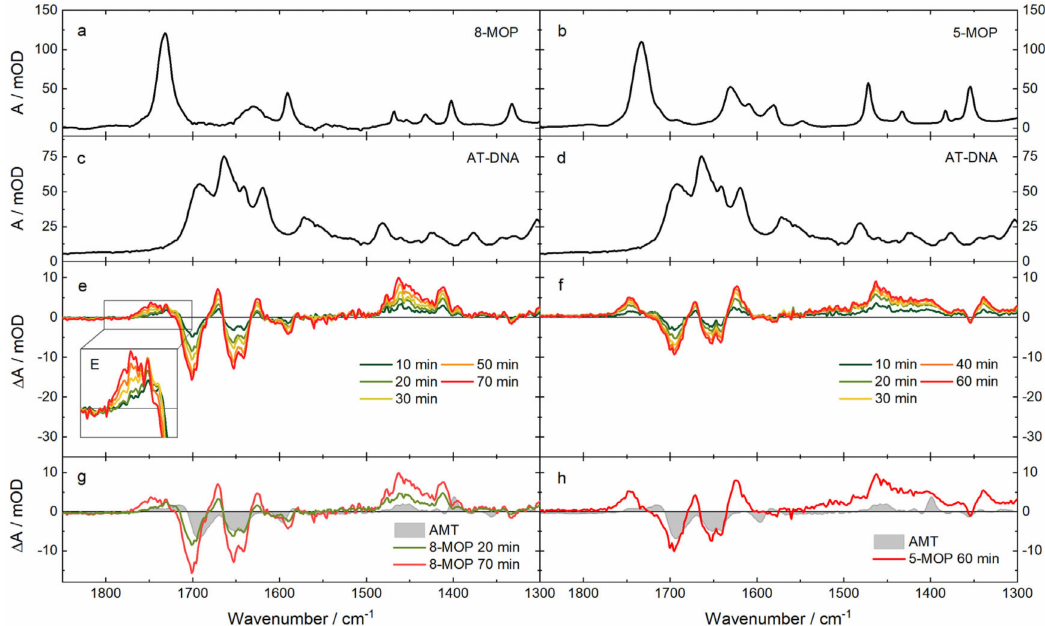
Figure 3. Steady-state IR spectra of the photoaddition of 8-MOP (left) and 5-MOP (right) to AT-DNA: ( a ) 8-MOP (11 mM) in acetonitrile-d3; ( b ) 5-MOP (10 mM) in acetonitrile-d3; ( c , d ) AT-DNA (7.7 mM) in PBS bu ff ered D 2 O; ( e ) Di ff erence spectra of the irradiation of 8-MOP (1.3 mM) with AT-DNA (20 mM) in PBS bu ff ered D 2 O ( λ exc = 375 nm, P = 26 mW). ( e ) Magnification of the marked range; ( f ) Di ff erence spectra of the irradiation of 5-MOP (0.7 mM) with AT-DNA (20 mM) in PBS bu ff ered D 2 O ( λ exc = 375 nm, P = 26 mW); ( g , h ) Comparison of di ff erence spectra obtained from the data in ( e , f ) with the one of AMT (1.5 mM) with AT-DNA (6.5 mM) ( λ exc = 375 nm, P = 15 mW)